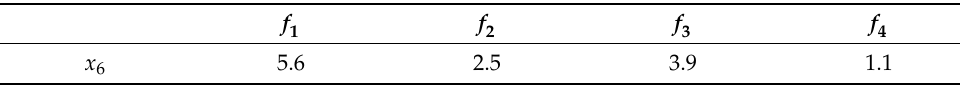
Figure 1. Example of classification of the iris dataset. Table 1. The feature values of test sample x 6 in the iris